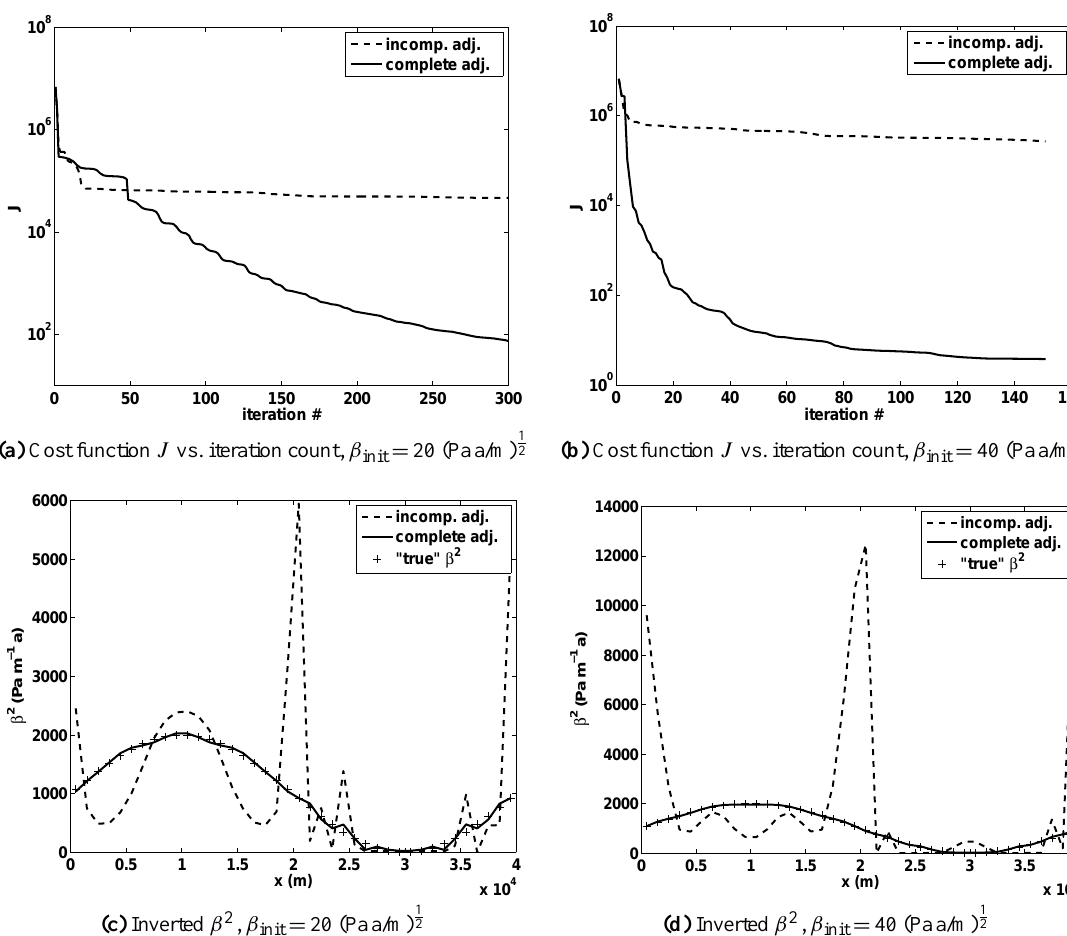
Fig. 1. Results of inversion for β 2 , using the flowline model with periodic boundary conditions and uniform thickness and basal slope. Domain length is 40km. “Observed” surface velocities are the results of a First Order flowline model calculated using “true” β from (c) and 1 1 (d) . Initial guess for β is set uniformly to 20 (Paa/m) 2 in the first column and to 40 (Paa/m) 2 in the second